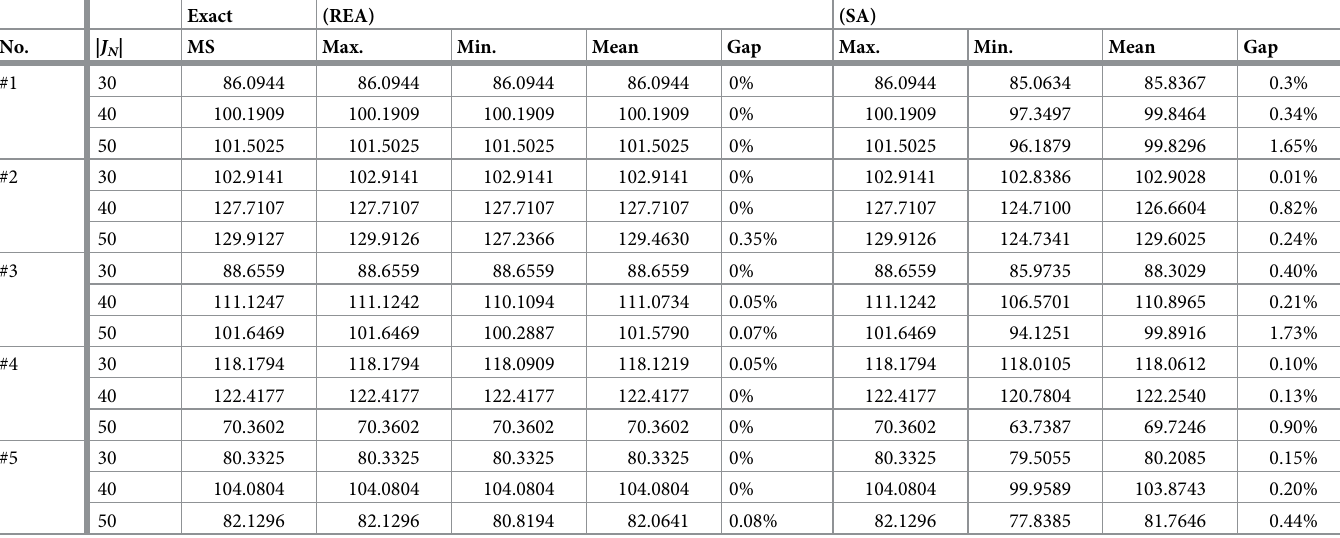
Table 2. Optimality of the algorithm